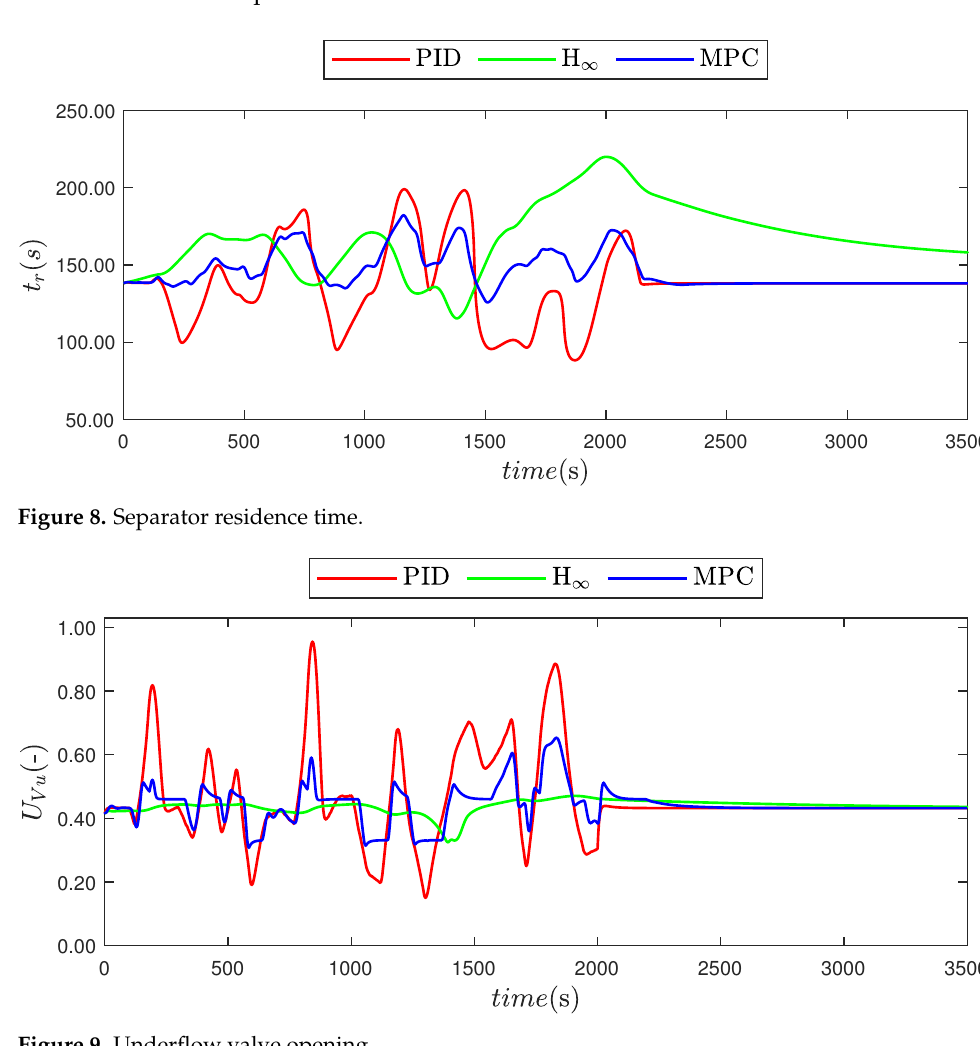
Figure 9. Underflow valve